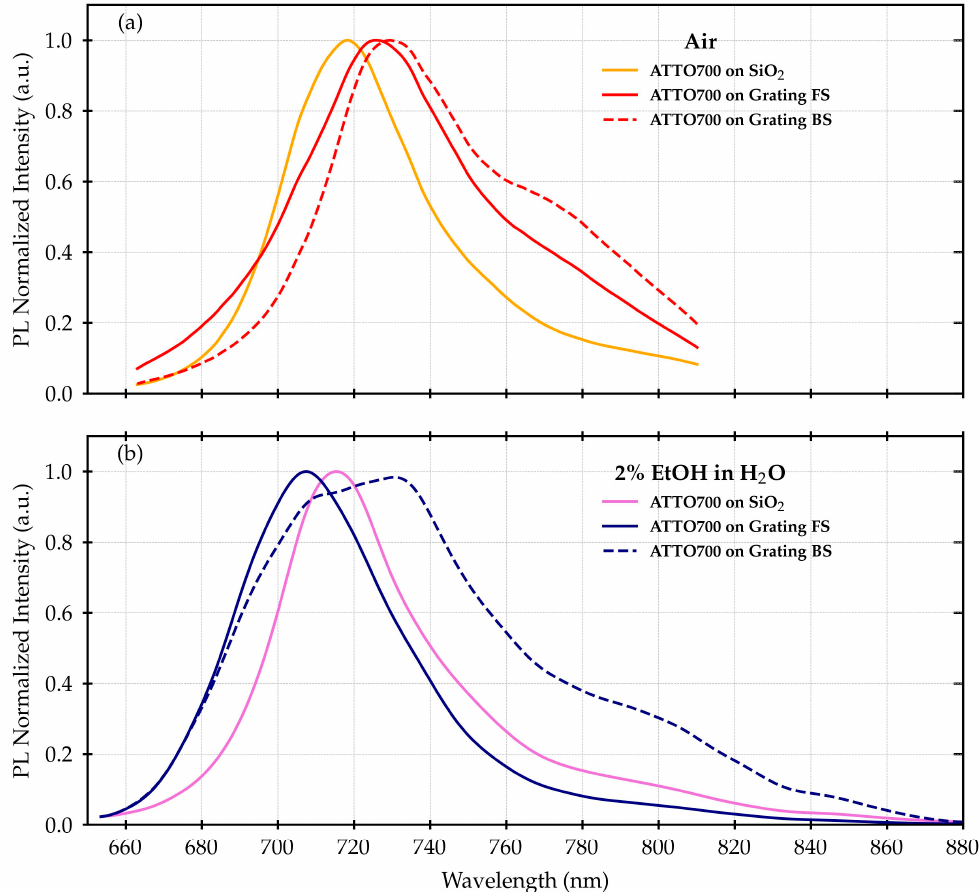
Figure 3. Normalized measured fluorescence spectra of ATTO700 dye deposited on the FS of the plasmonic grating and the reference SiO 2 slide measured with the active surface exposed to air ( a ) and a 2% EtOH in water solution ( b ).